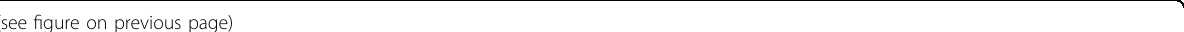
Fig. 5 PBM boosted ATP production and differentially regulated protein expression in the hippocampus. A After UWT, rats were restrained together with or without receiving PBM treatment. Rats were sacri fi ced at 3 h post PBM treatment. B Acute stress-induced higher ATP production in UWT-group. PBM further increased ATP in the hippocampus of PBM-group rats. C Amygdala ATP content was unchanged, and PBM had no treatment effects. D Plasma corticosterone was increased in UWT-group, compared with the ctrl-group. PBM treatment had no treatment effects. n = 9, 12, 12 for ctrl, UWT, PBM-group, respectively. * P < 0.05 versus UWT-group; # P < 0.05 versus ctrl-group. E The volcano plot of proteins identi fi ed by mass spectrometry ( n = 3 each group). Left panel (UWT/ctrl): the dots above the orange line ( P = 0.05) are the proteins that were signi fi cantly decreased (left side of the Y-axis) or increased (right side) in the UWT-group as compared with the ctrl-group (UWT/ctrl). Right panel (PBM/UWT): more dots on the left side of the Y-axis than the right side indicates that PBM down-regulated the proteins that were over-expressed by UWT. F A two-dimension plot for the ratio of UWT/ctrl and PBM/UWT. G The heat map for the expression pro fi les of 39 proteins identi fi ed with signi fi cantly differential expression (UWT vs. ctrl). Each column represents an individual rat belonging to a certain group. H The proportion and classi fi cation of the 39 identi fi ed proteins. I Con fi rmation of the mass spectrometry results with Western blot. Top panel: Representative protein expression fi les from the rats in ctrl, UWT, and PBM-group. Middle and bottom panel: the quanti fi cation of Western blot results for TIF1 β and TRAP1. * P < 0.05 versus UWT- group; ## P < 0.01 versus